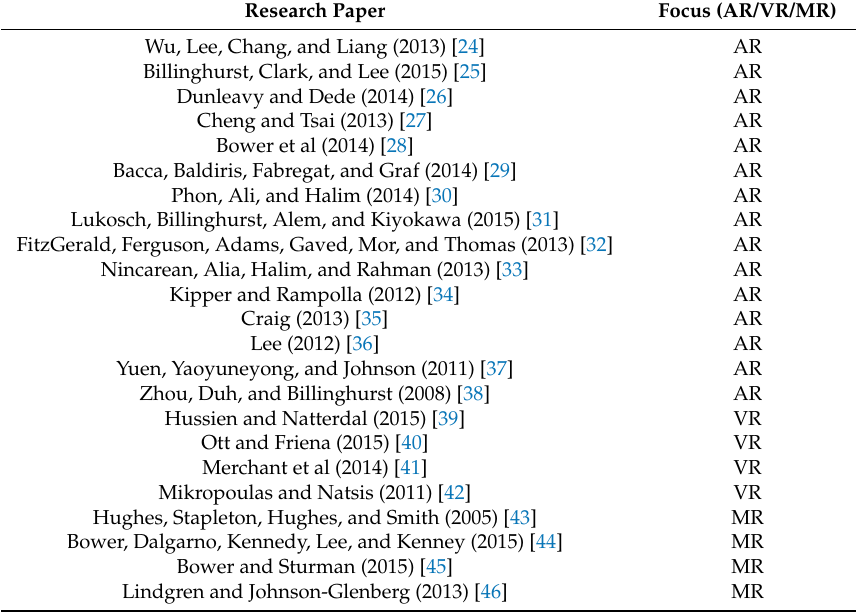
Table 1. An Analysis of Review Papers on AR/virtual reality